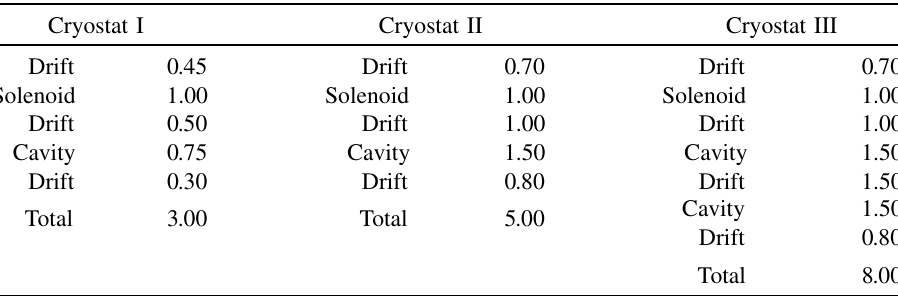
TABLE IV. Linac cryomodule structure. Numbers are lengths in m.